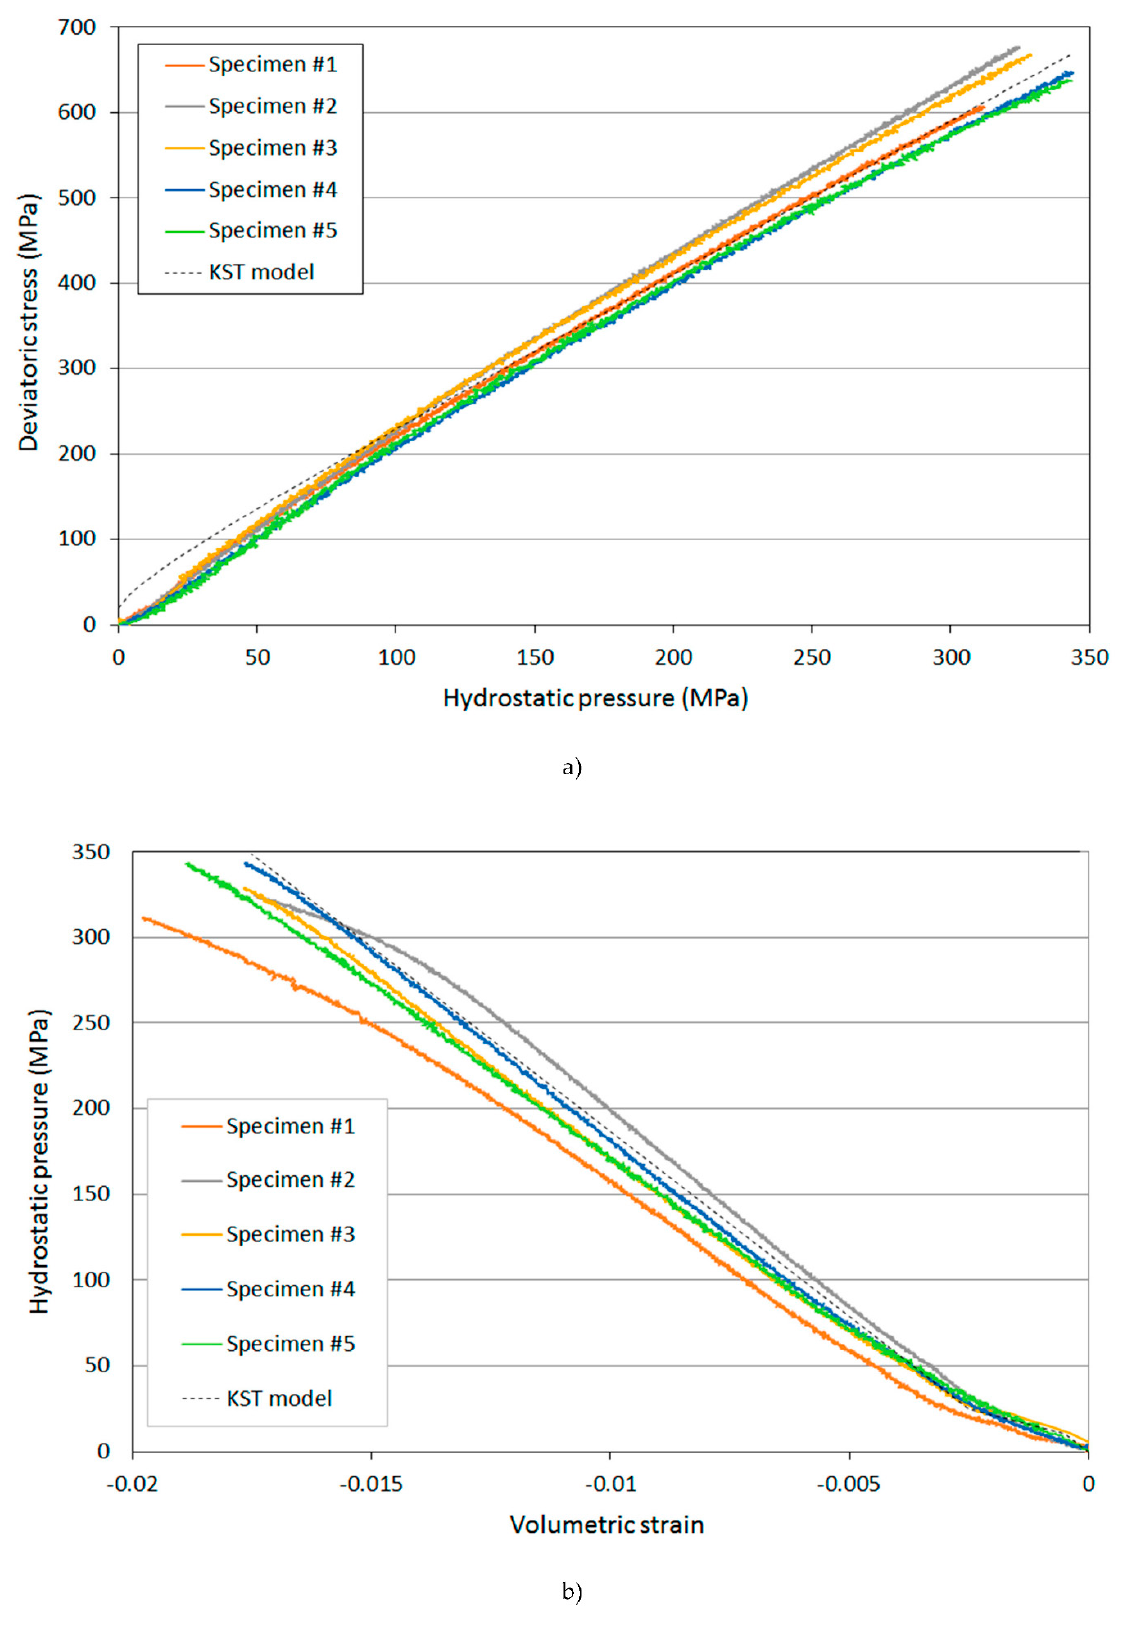
Figure 10. Result of quasioedometric compression test. ( a ) Deviatoric response in sandstone samples #1 to #5 (loading); ( b ) Volumetric response in sandstone samples #1 to #5 (loading).